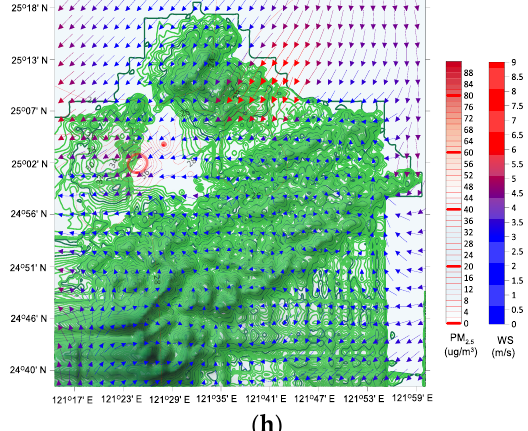
Figure 10. Distribution of mean PM 2.5 ( µ g · m − 3 ), mean wind speed (m · s − 1 ), and the resultant vectors (degree) in the Taipei metropolis: ( a ) BE1; ( b ) E1; ( c ) BE2; ( d ) E2; ( e ) AE2; ( f ) BE3; ( g ) E3; ( h ) AE3. BE1: before event one stage; E1: during event one stage; BE2: before event two stage; E2: during event two stage; AE2: after event two stage; BE3: before event three stage; E3: during event three stage; AE3: after event three stage.